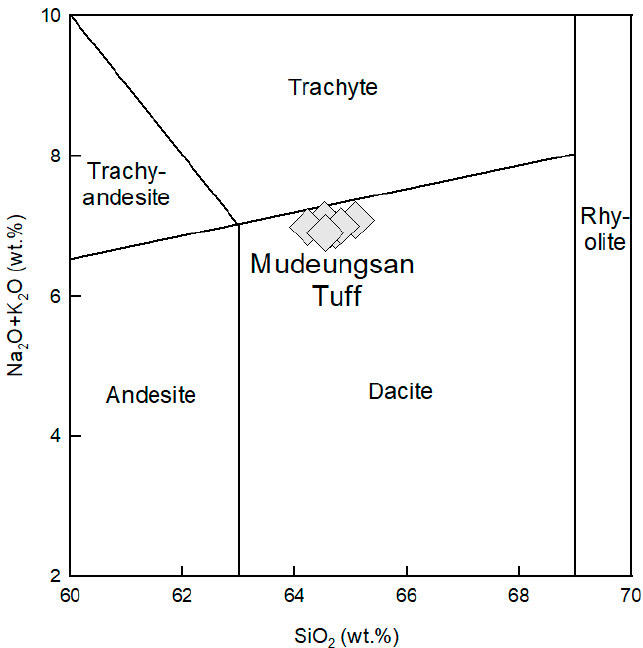
Figure 3. Total alkali–silica (TAS) diagram [10] using chemical analysis results (Table 1). The stacked synchrotron X-ray diffraction patterns and phase identification results